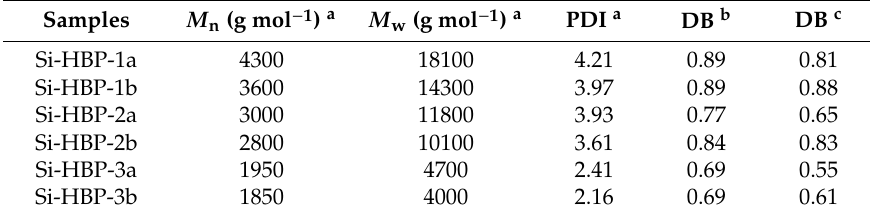
Table 2. GPC data of Si-HBP-1 to